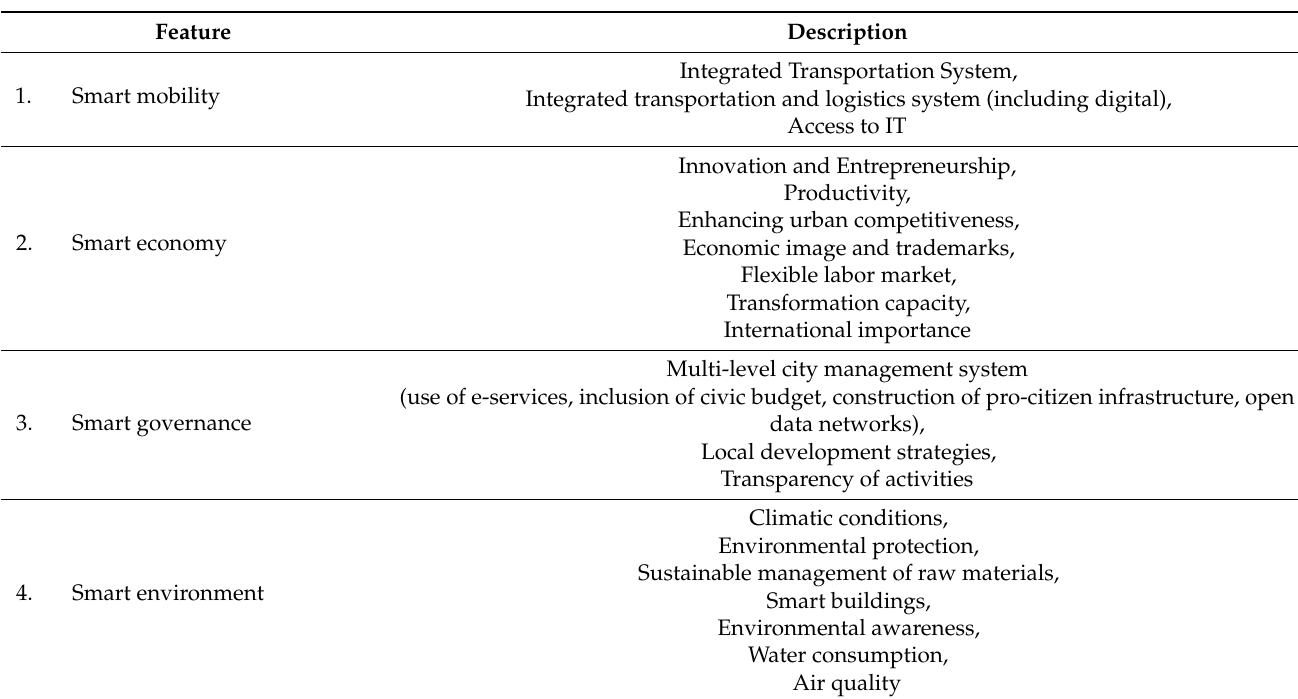
Table 1. Seven characteristics of the new era smart